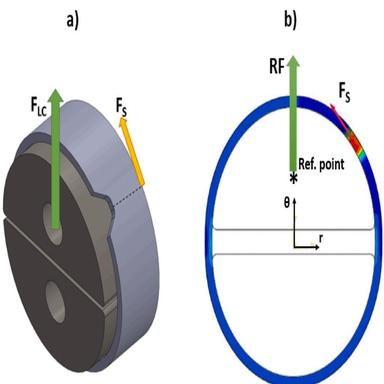
(a) Schematic representation of the force section along the gauge of the RHPST specimen; (b) representation of the monitoring of the force perpendicular to the section of the gauge zone of the RHPST specimen.